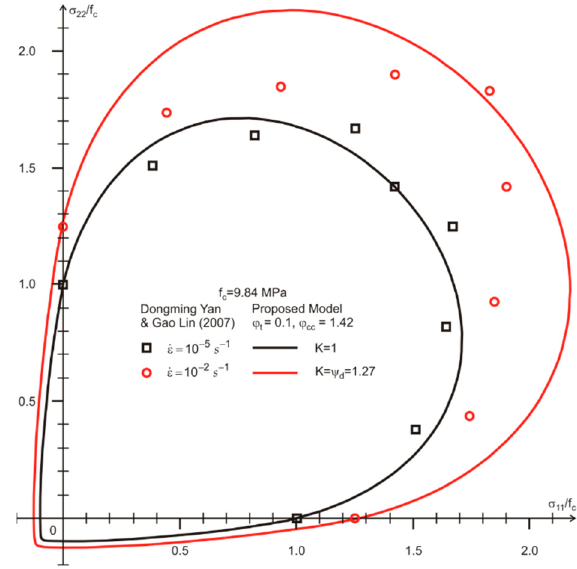
Figure 9. Comparison of the proposed dynamic strength criterion with experimental results by Yan and Lin [49] for biaxial compressive–compressive loading tests.